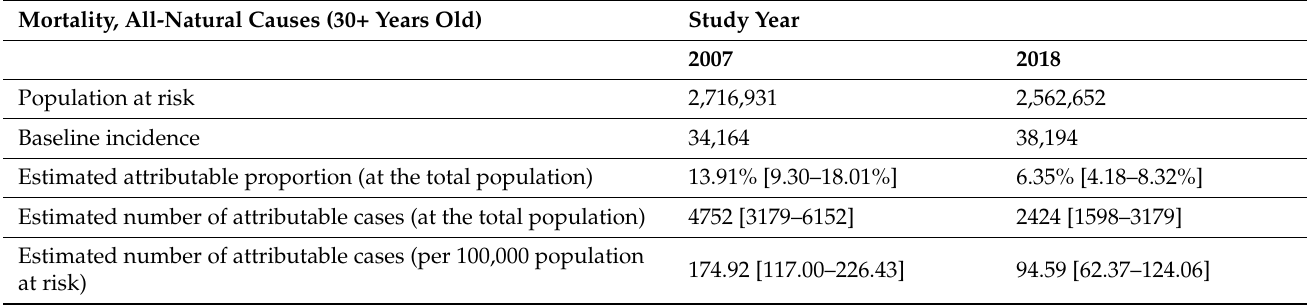
Table 4. Health impact assessment for PM 2.5 (all-natural causes, COPD, lung cancer, IHD and